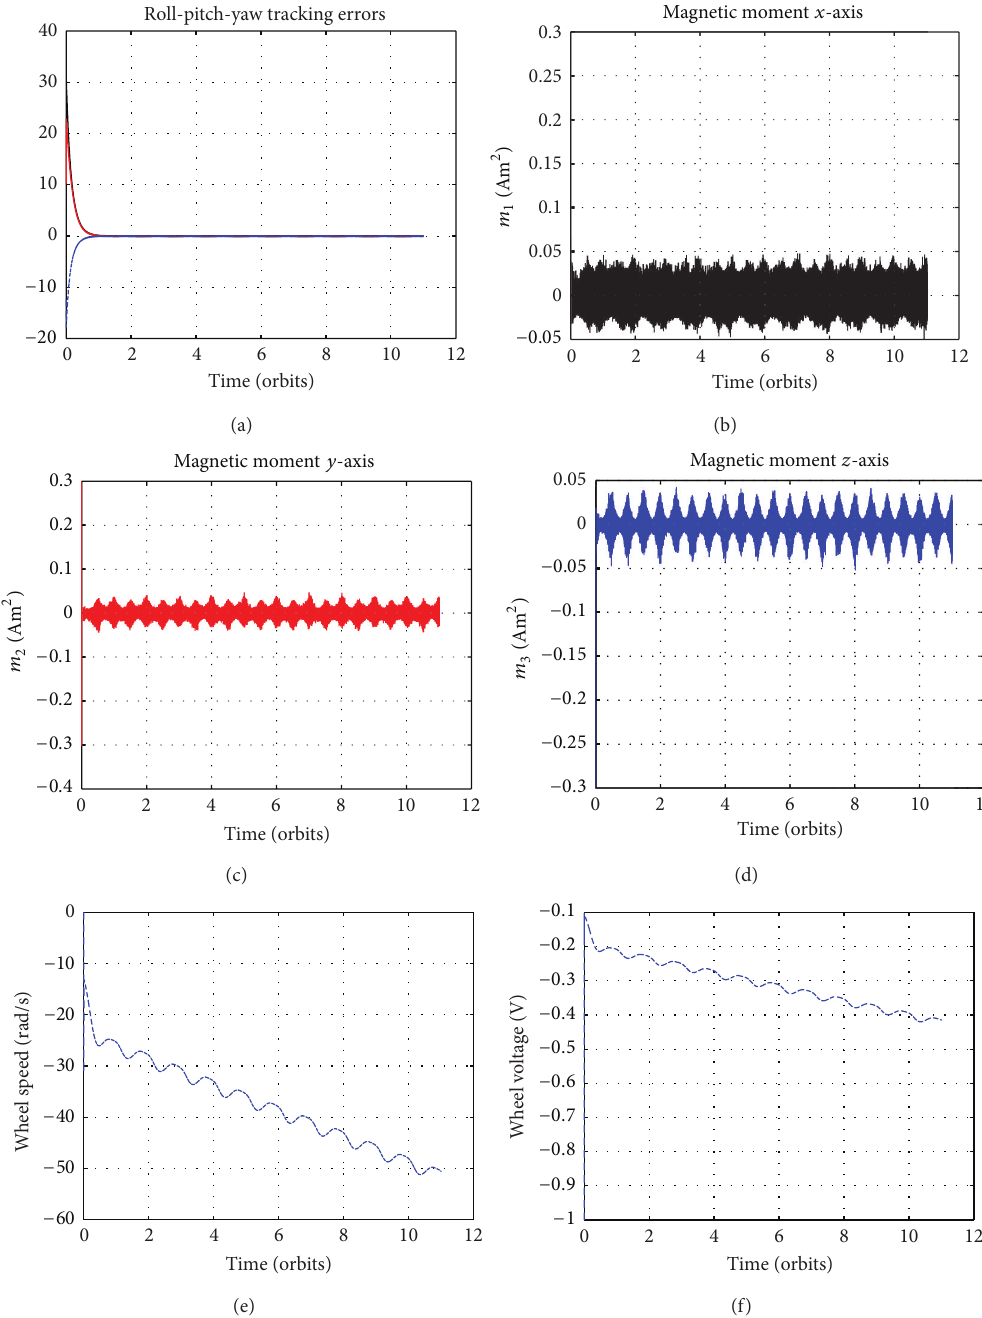
Figure 10: Scenario 4 nadir pointing control results using one reaction wheel and three